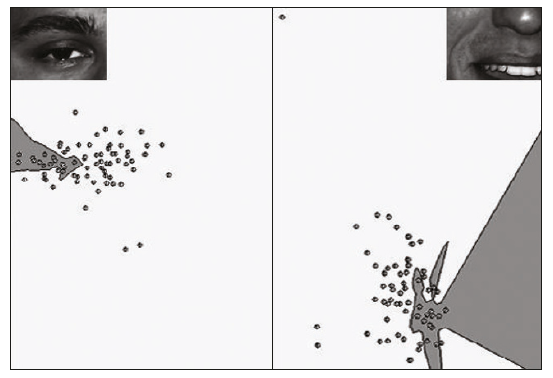
Figure 6: Trainings and test class spaces for eye sample data using LOC features.